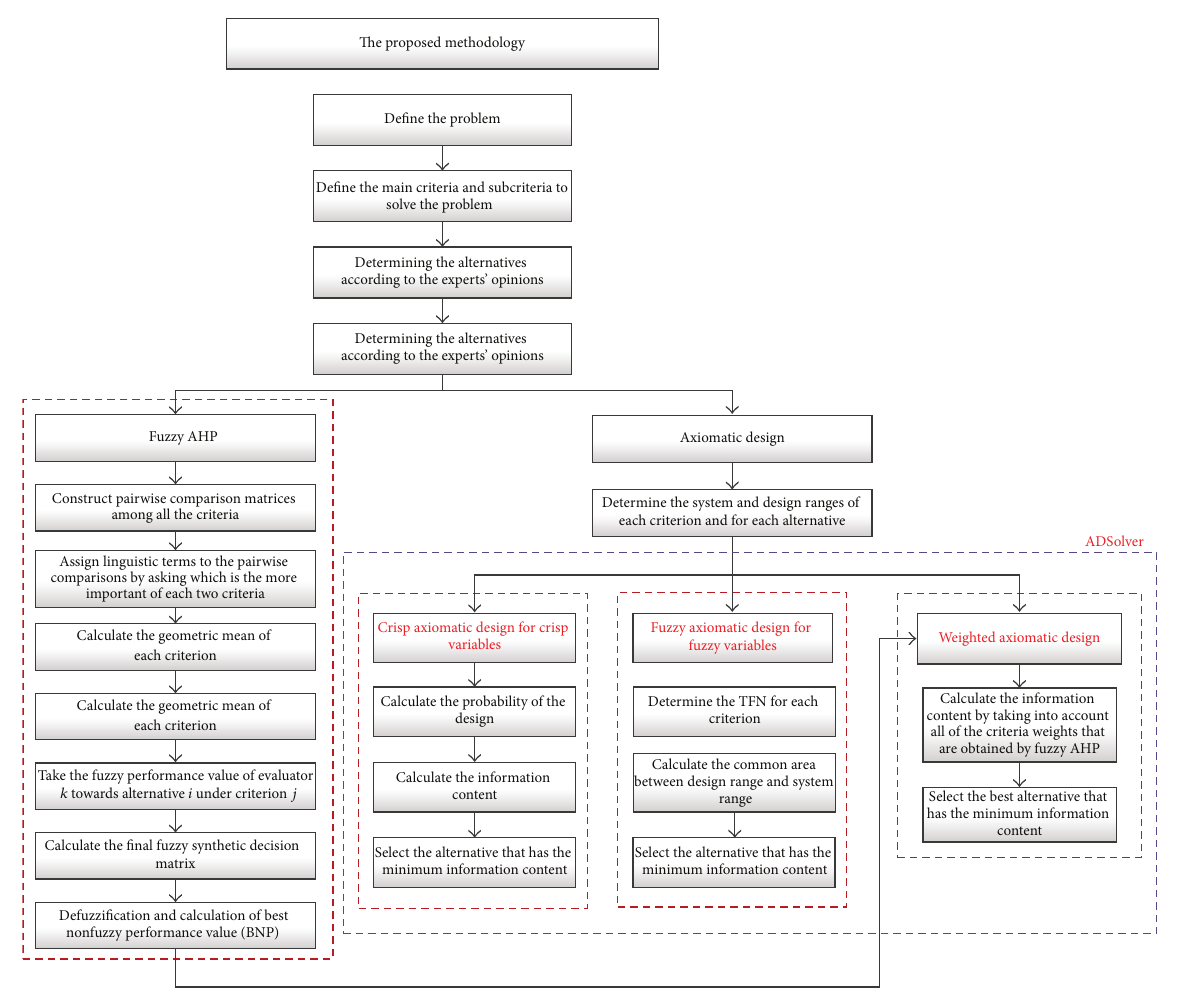
Figure 1: The proposed